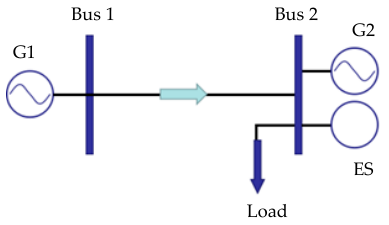
Figure 2. Single line diagram for the two-bus network.